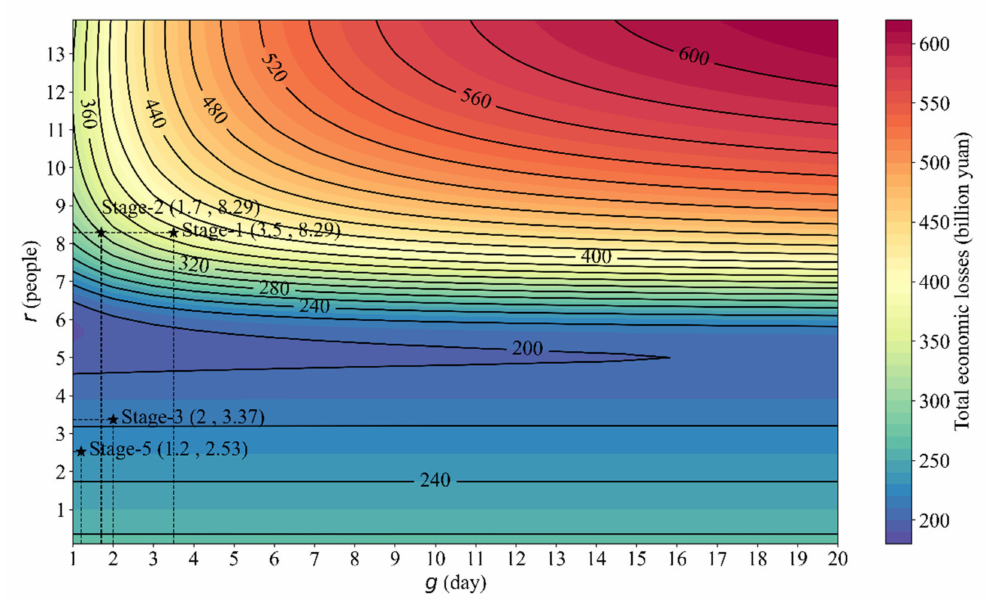
Figure 6. The contour map of total economic losses in Wuhan under various gridded control measures ( r and g ), where r is the effective number of daily contacts; g is the average waiting time for quarantined patients. Total economic losses ranged from CNY 188.81 to 618.70